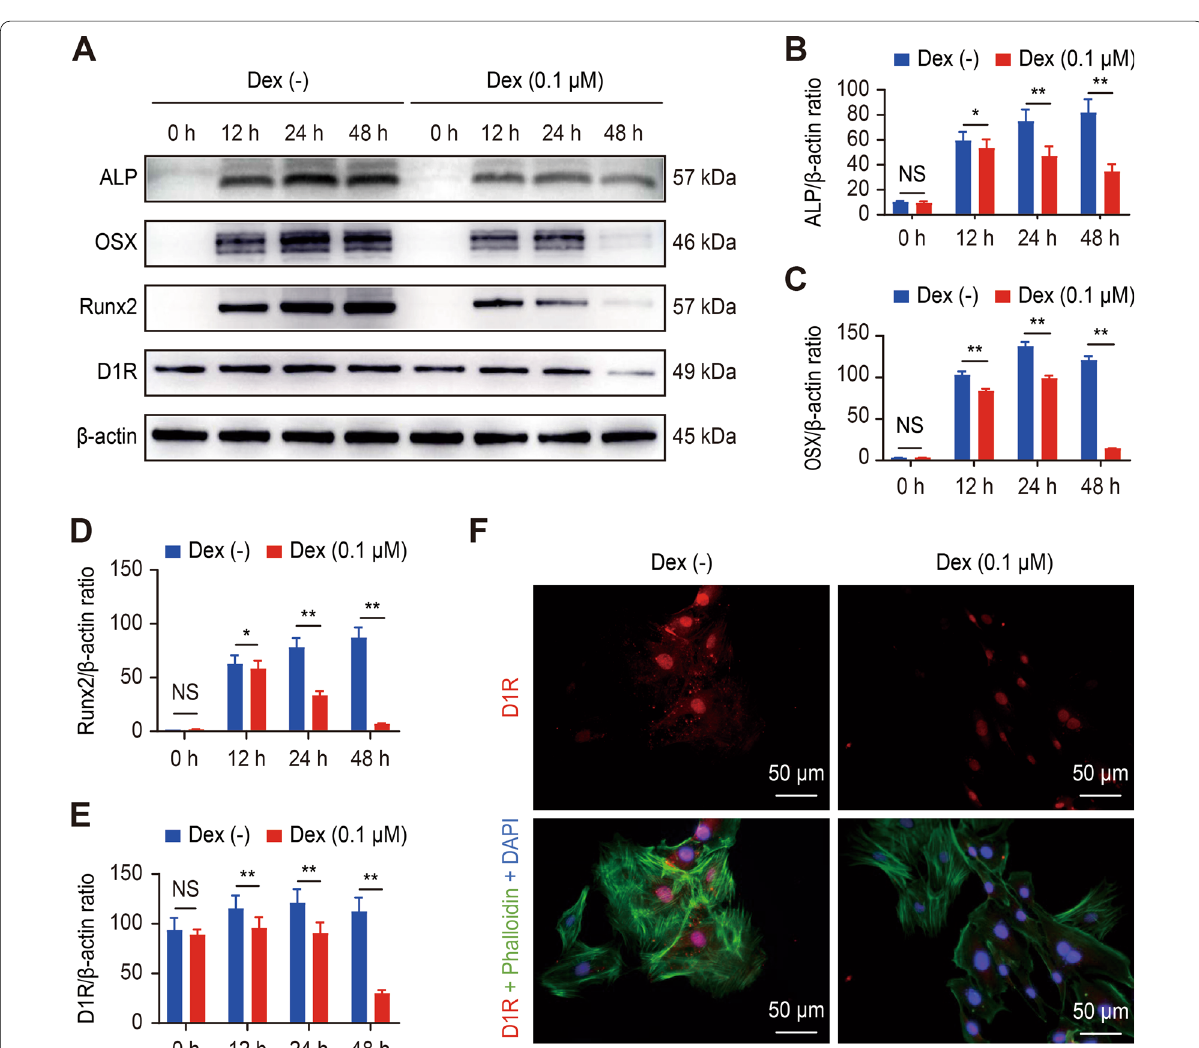
Fig. 2 Dex inhibited the differentiation of osteoblasts and reduced D1R expression in vitro. A Representative images of western blots probed with antibodies against ALP, OSX, Runx2, and D1R. B – E Quantification of ALP, OSX, Runx2, and D1R protein levels. n significant, * p < 0.05, ** p < 0.01, vs. the Dex ( ) group at the same time point. F Representative images showing immunofluorescence staining of − D1R. Scale bar: 50